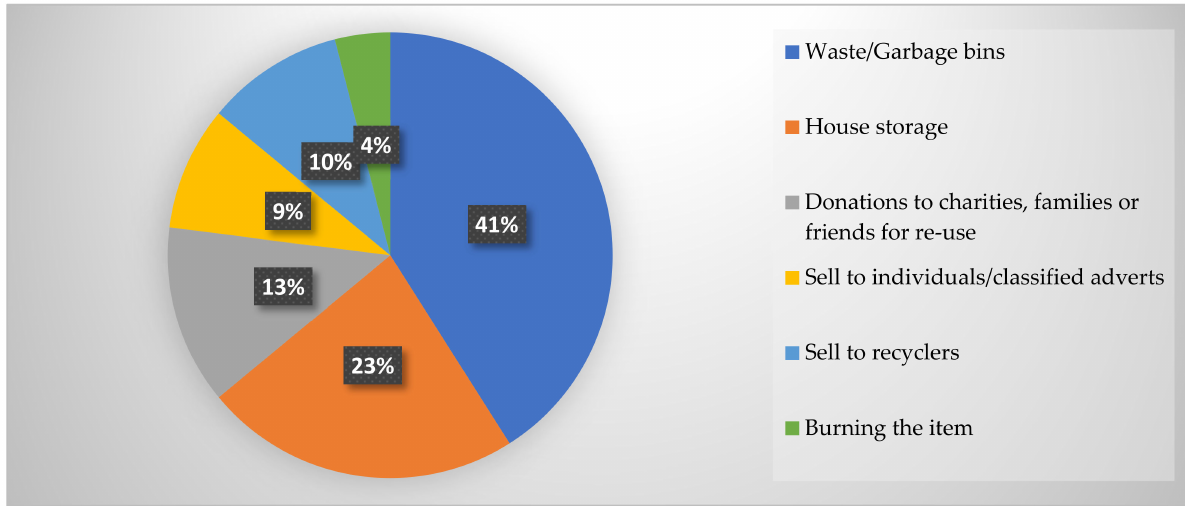
Figure 5. E-waste disposal methods by